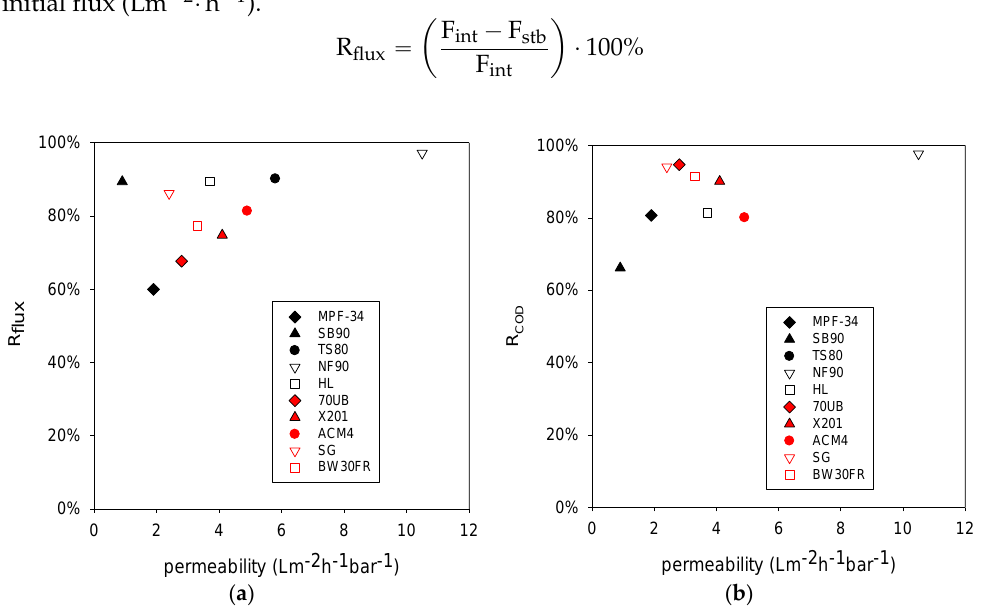
Figure 3a illustrates the role that membrane permeability plays on reduction of flux. Percentage reduction of flux (R flux ) was calculated using Equation (1). F stb is the stable flux (Lm −2 ·h −1 ), and F int is the initial flux (Lm −2 ·h −1 ).